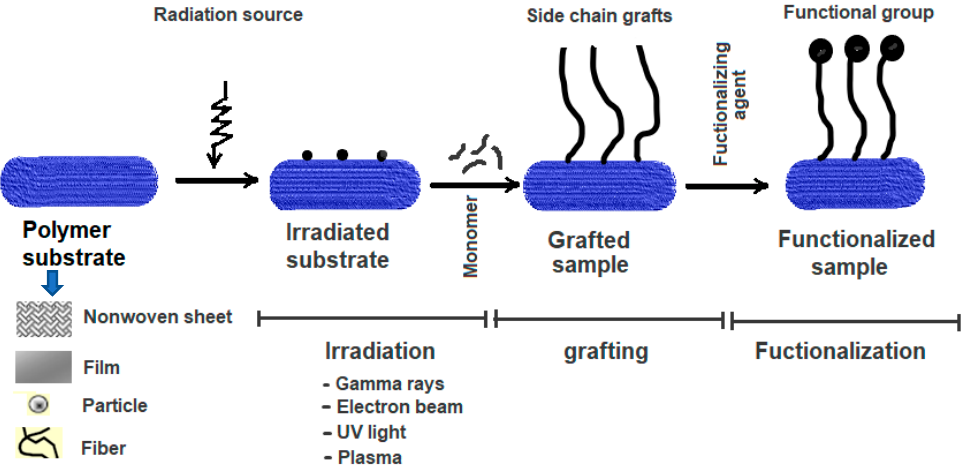
Figure 1. Schematic representation for preparation of functional polymeric materials by RIGC and functionalisation.